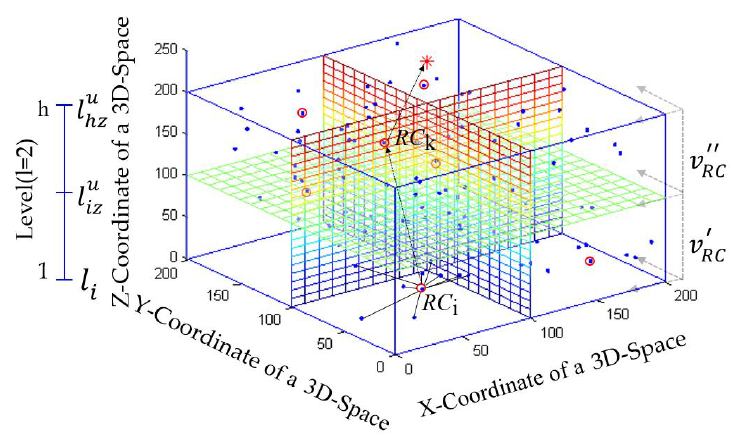
Figure 1. An example of forwarding routing centroid (RC) node selection.